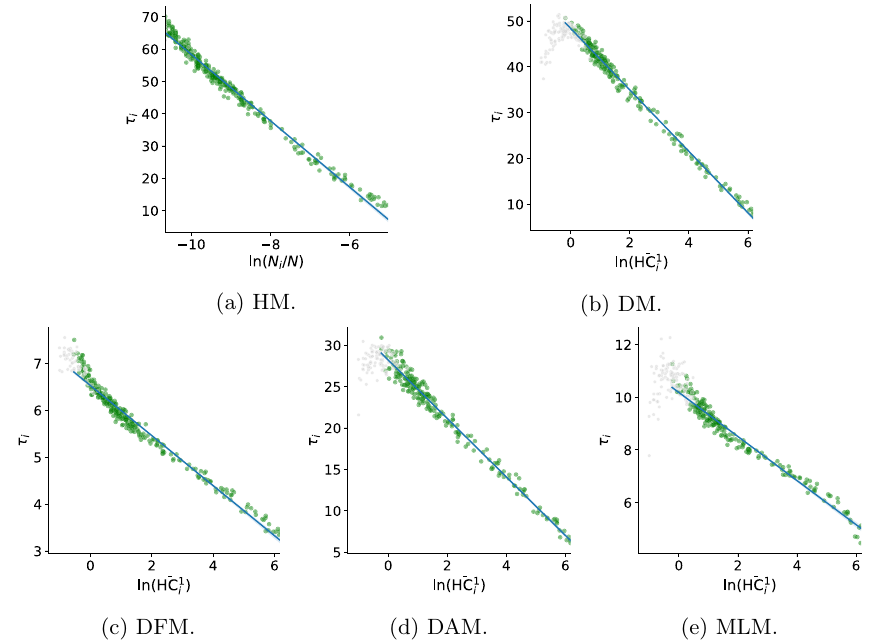
1 i for the five considered